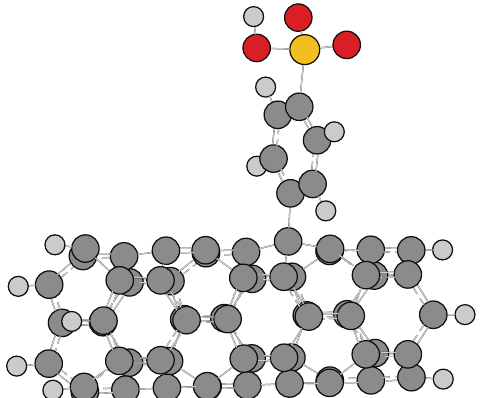
Figure 5: Optimized geometry of the finite (5, 0) zigzag SWCNT (C 60 H 20 ) with the benzenesulfonic acid radical at the tube sidewall. Gray color depicts carbon atoms; light gray is hydrogen, yellow is sulfur and red is